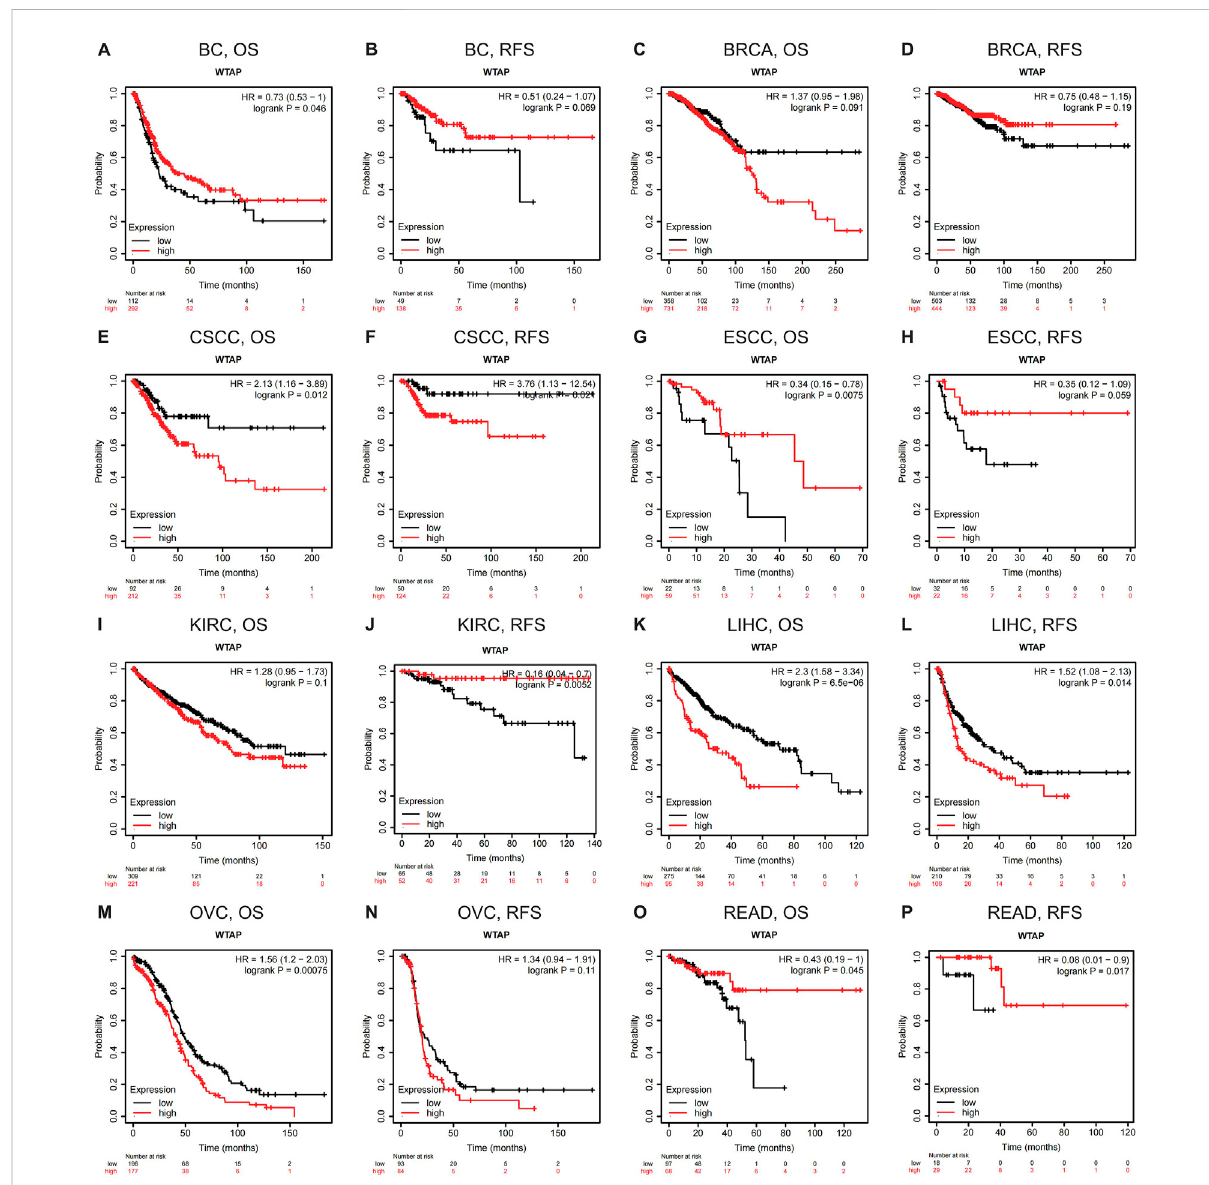
FIGURE 3 Kaplan-MeiersurvivalcurvescomparingthehighandlowexpressionofWTAPindifferenttypesofcancerinKaplan-MeierPlotter.OSandRFSof (A,B) bladder carcinoma (BC) (C,D) breastcancer (BRCA) (E,F) cervicalsquamouscell carcinoma (CSCC) (G,H) esophagealsquamouscell carcinoma (ESCC) (I,J) kidney renal clear cell carcinoma (KIRC) (K,L) liver hepatocellular carcinoma (LIHC) (M,N) ovarian cancer (OVC), and (O,P) rectum adenocarcinoma (READ). Red curve represents patients with high expression of WTAP. OS, overall survival; RFS, relapse-free